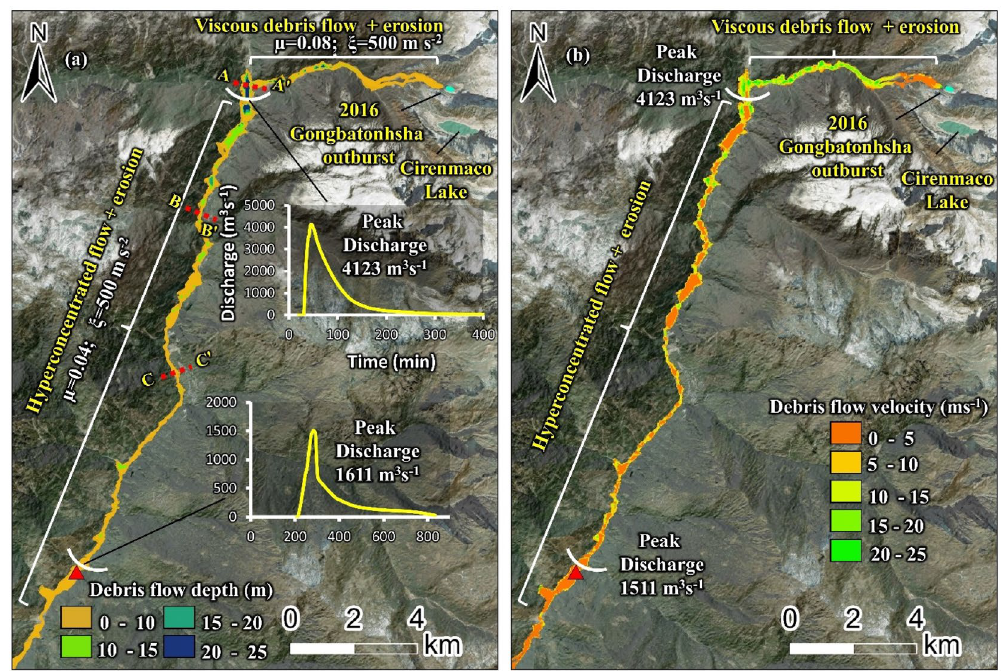
Figure 5. Reconstructed flow hydraulics of the 2016 Gongbatongsha GLOF and flow transformation; ( a ) spatially distributed flow depth (m); ( b ) flow velocity (m s −1 ). Background: ESRI base map overlaid on ALOS PALSAR DEM; (© Esri, Maxar, GeoEye, Earthstar Geographics, CNES/Airbus DS, USDA, USGS, AeroGRID, IGN, and the GIS User Community). This map was created using ArcMap 10.8 software (© ESRI, URL: https:// www. esri. com/ en- us/ arcgis/ produ cts/